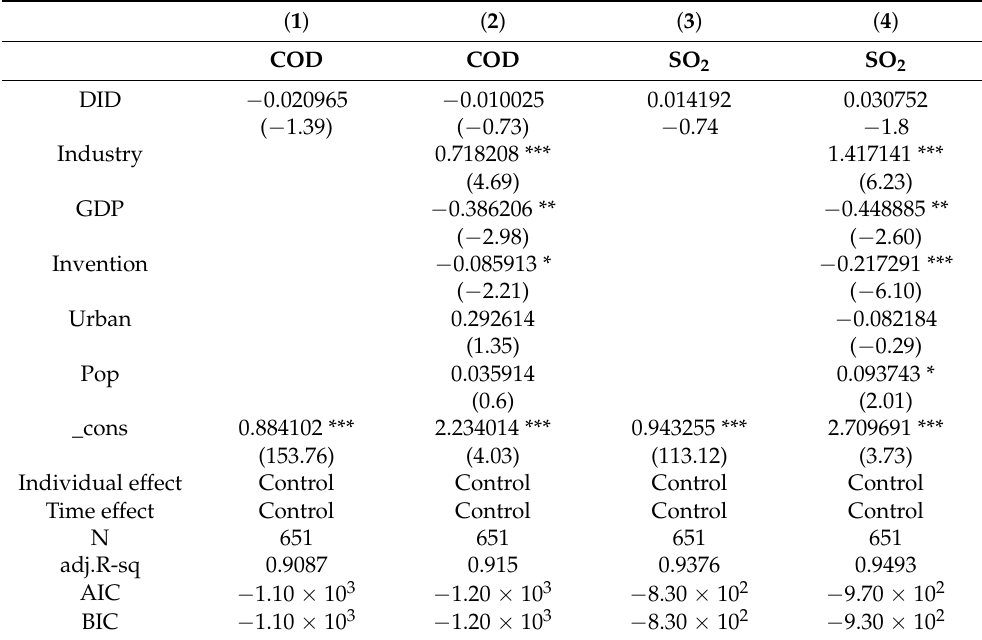
Table 3. Placebo test.